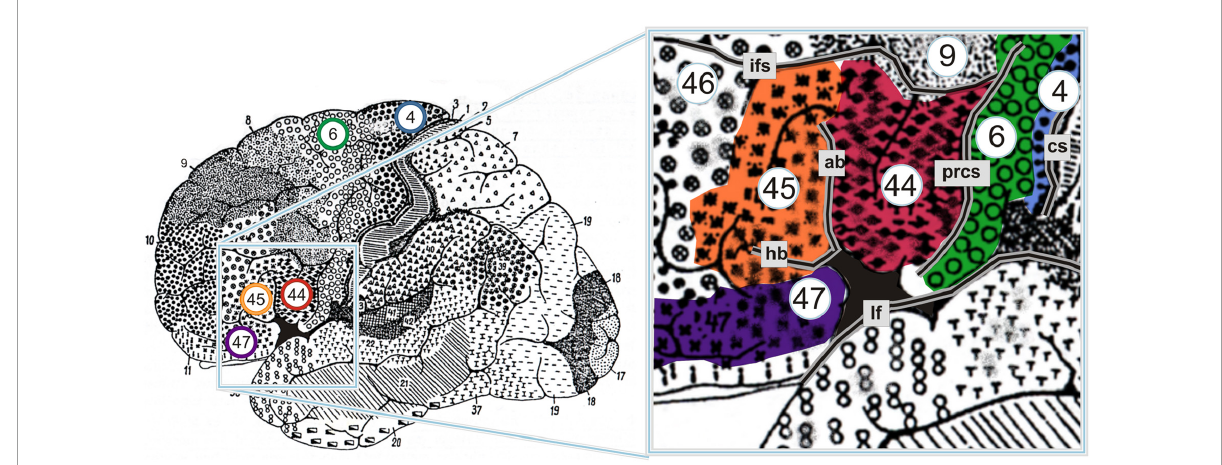
FIGURE1 Cytoarchitectonic map of Brodmann areas (BAs) on the lateral surface of the left hemisphere. BAs 44 and 45 are traditionally regarded as comprising Broca’s area; some scholars argue, however, that BA47 should be grouped together with the other two to form “Broca’s complex” (for controversies over the definition of Broca’s area, see Tremblay and Dick, 2016). Note that the deep sulcal portions of these areas are not visible here. ab, ascending branch of the lateral fissure; cs, central sulcus; hb, horizontal branch of the lateral fissure; ifs, inferior frontal sulcus; lf, lateral fissure; prcs, precentral sulcus. From Amunts et al. (2010), p. 2. This material is open